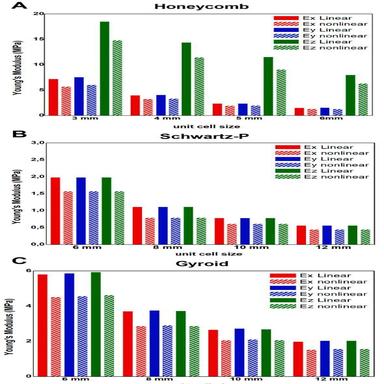
Comparison of linear (striped columns) and hyperelastic (full columns) FEM-derived compressive moduli along the x, y, and z directions of (A) honeycomb, (B) schwartz-P, and (C) gyroid matrix soft lattice scaffolds with different unit cell sizes.